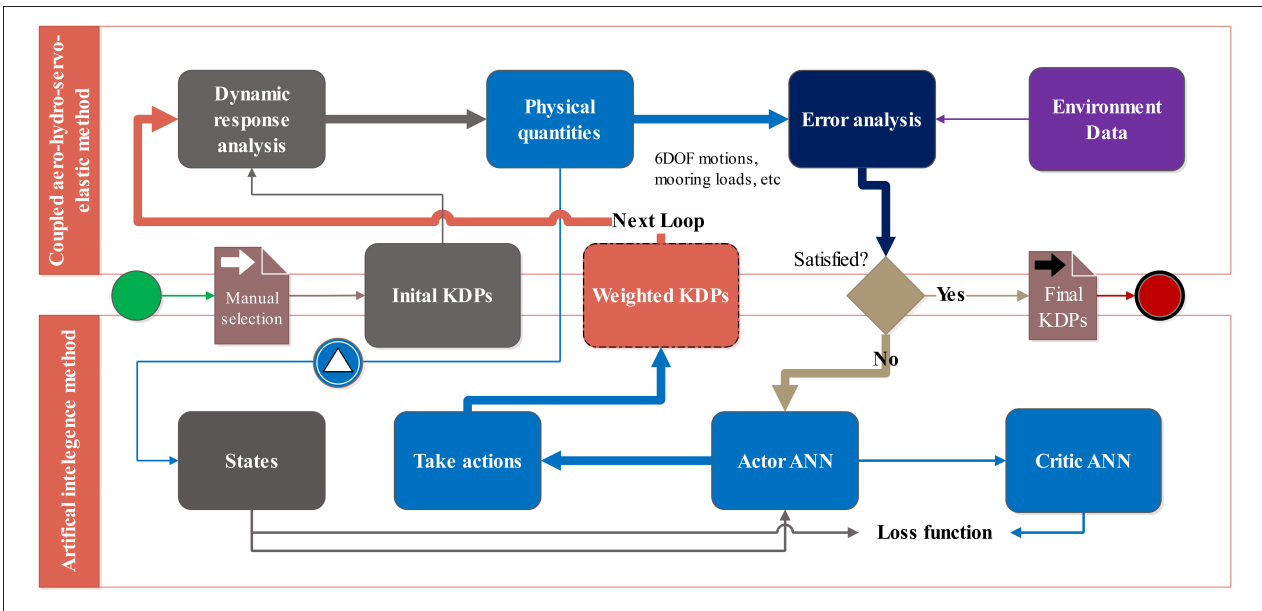
FIGURE 1 | The overall layout of proposed SADA